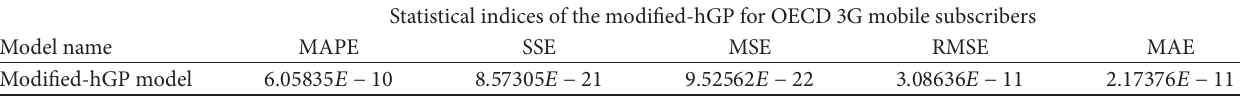
Table 5: Statistical indices in fitting process of the modified-hGP model for the OECD 3G mobile subscribers. Statistical indices of the modified-hGP for OECD 3G mobile subscribers